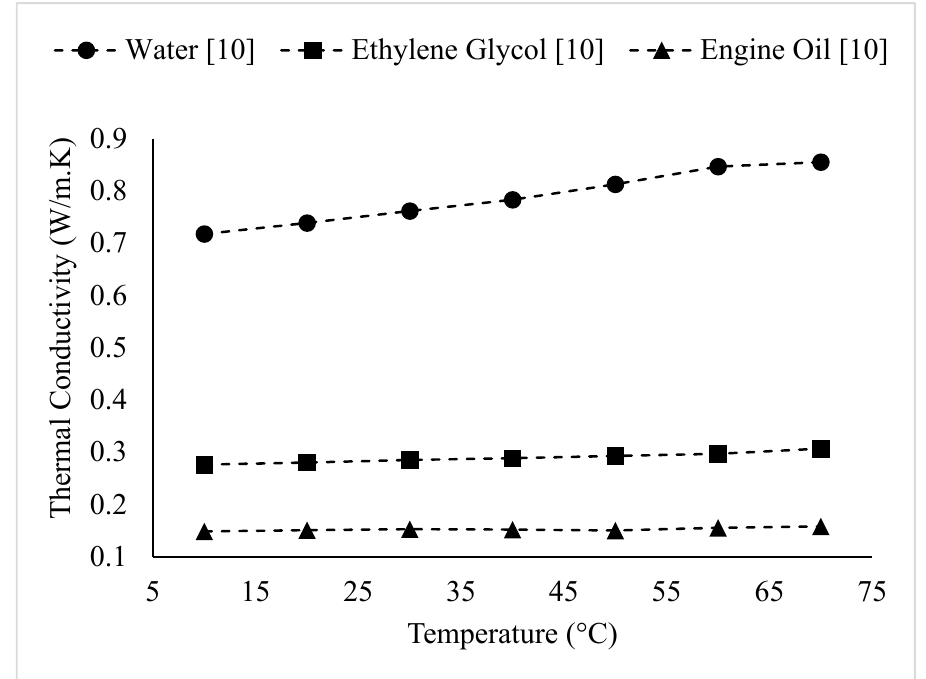
Figure 12. Variation of CuO nanofluid thermal conductivity as a function of temperature for different base liquids, at 𝜑 = 2%.